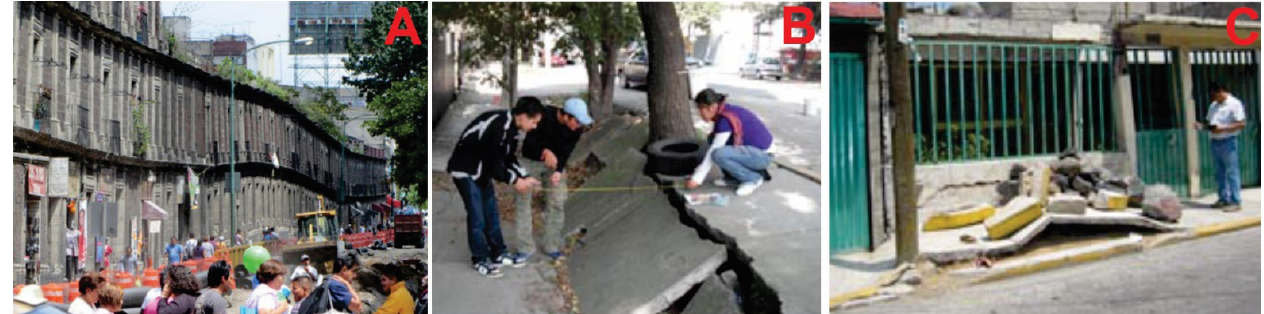
Figure 6. Damage due to land subsidence in Mexico City. ( A ) Vertical differential deformation [94] . ( B , C ) Damage to infrastructure [95] . ( B , C ) Damage to infrastructure